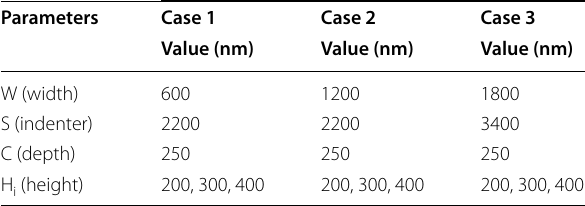
Table 1 Dimensions of the silicon stamp for the NIL